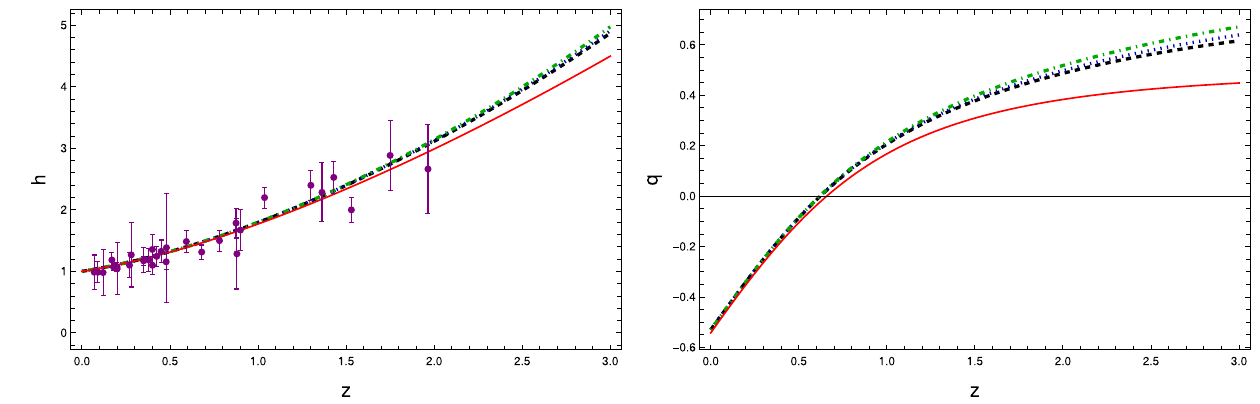
Fig. 5 The Hubble function h ( z ) and the deceleration parameter q ( z ) for the general quadratic conformally invariant Weyl geometric model (95), for lower 2 σ limit (dashed), best fit (dot-dashed), and upper 2 σ